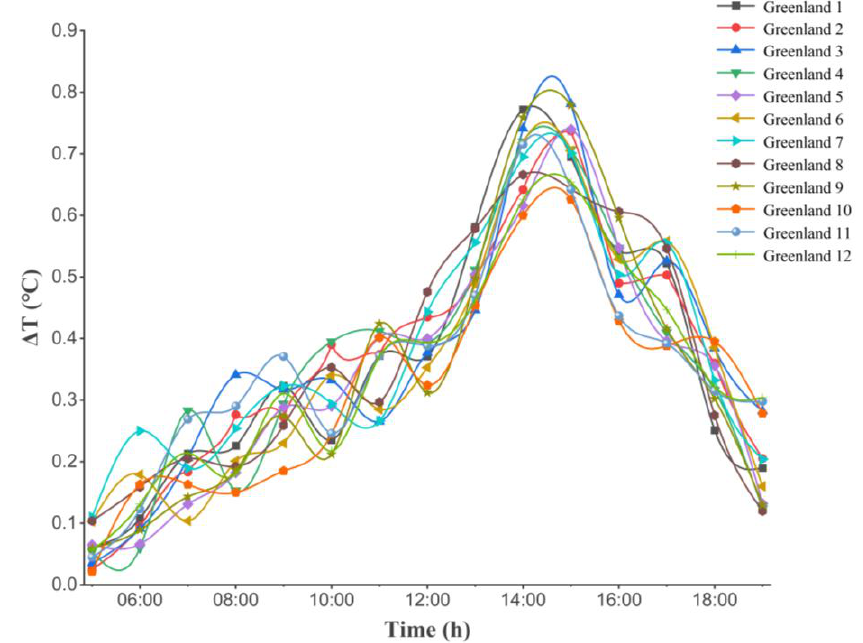
Figure 7. Cooling effects of 12 greenbelts near tested location.